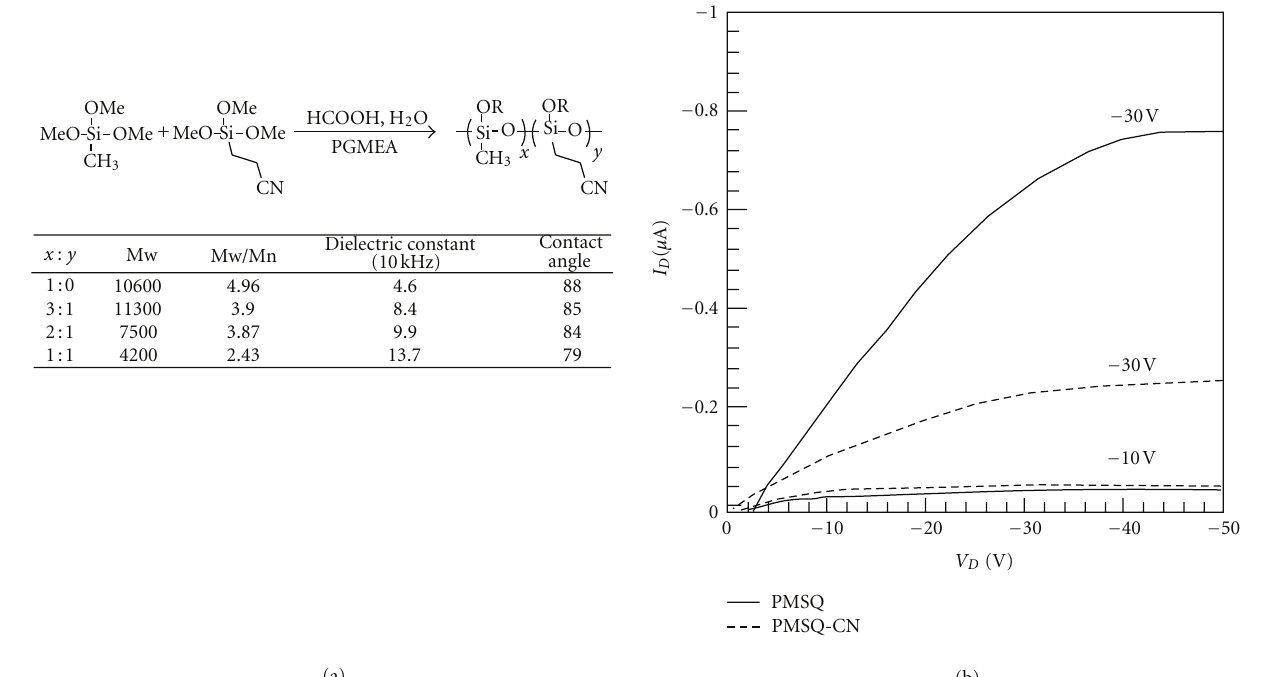
Figure 13: Synthesis of copolysilsesquioxane (PMSQ-CN) and their properties (a), and output characteristics of P3HT TFT with PMSQ gate-insulating layer (dashed lines) and PMSQ-CN gate-insulating layer (solid lines) at V G = − 10 and − 30 V (b).